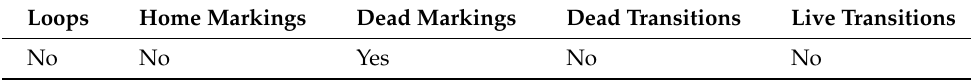
Table 6. State-space analysis results of the Rechained CPN model. Loops Home